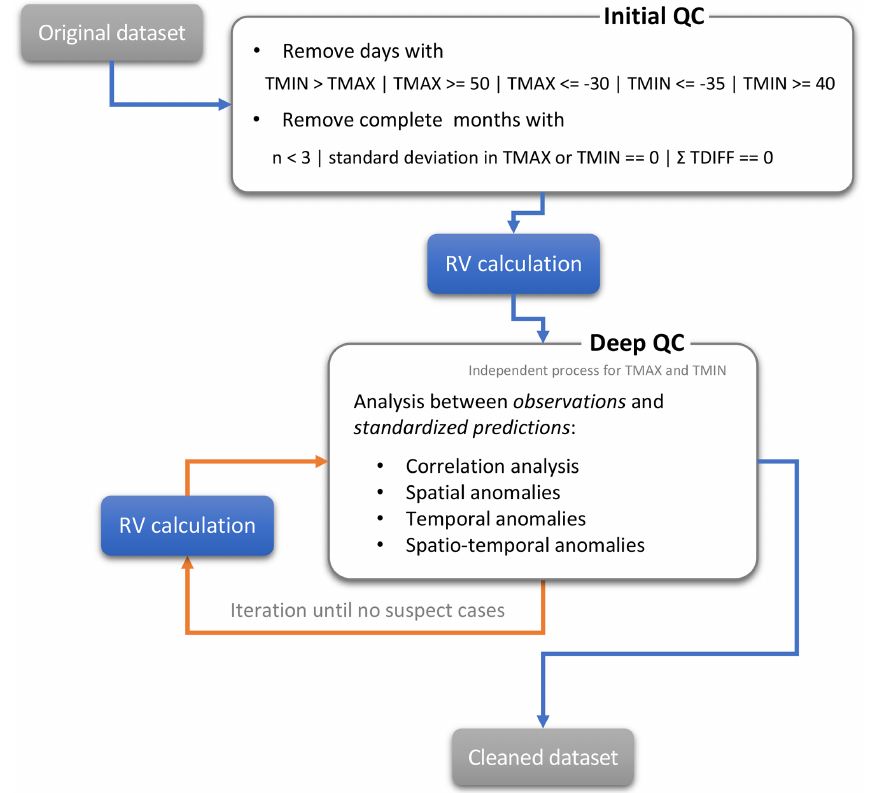
Figure 4. Methodological protocol for quality